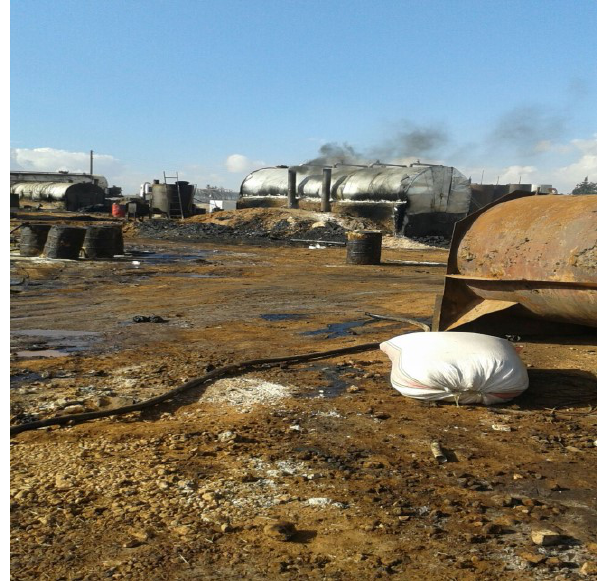
Figure 9. Soil and air pollution from oil refining.